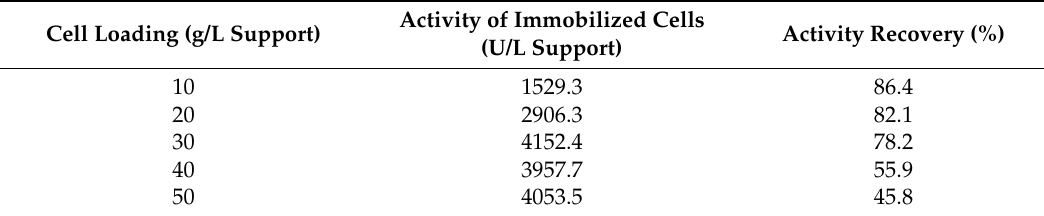
Table 1. Influence of the quantity of E. coli cells on the immobilization procedure. The suspension of E. coli cells and the gellan gum (1%, w / v ) were mixed at a ratio of wet cell weight to dry gellan gum of 1–5 ( w / w ) in 50 mM Tris-HCl buffer, pH 7.5. The activity of permeabilized cells is 177 U/g wet cell weight. Cell Loading (g/L Support)